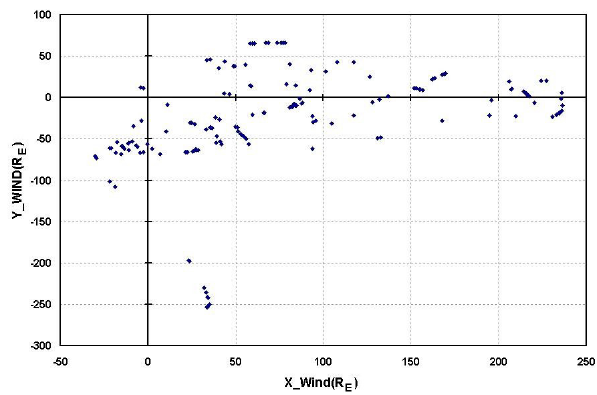
Fig. 10. WIND positions for all 178 events in the data set (Novem- ber 1997 → September 2000) in the GSE (X,Y) plane, in R E